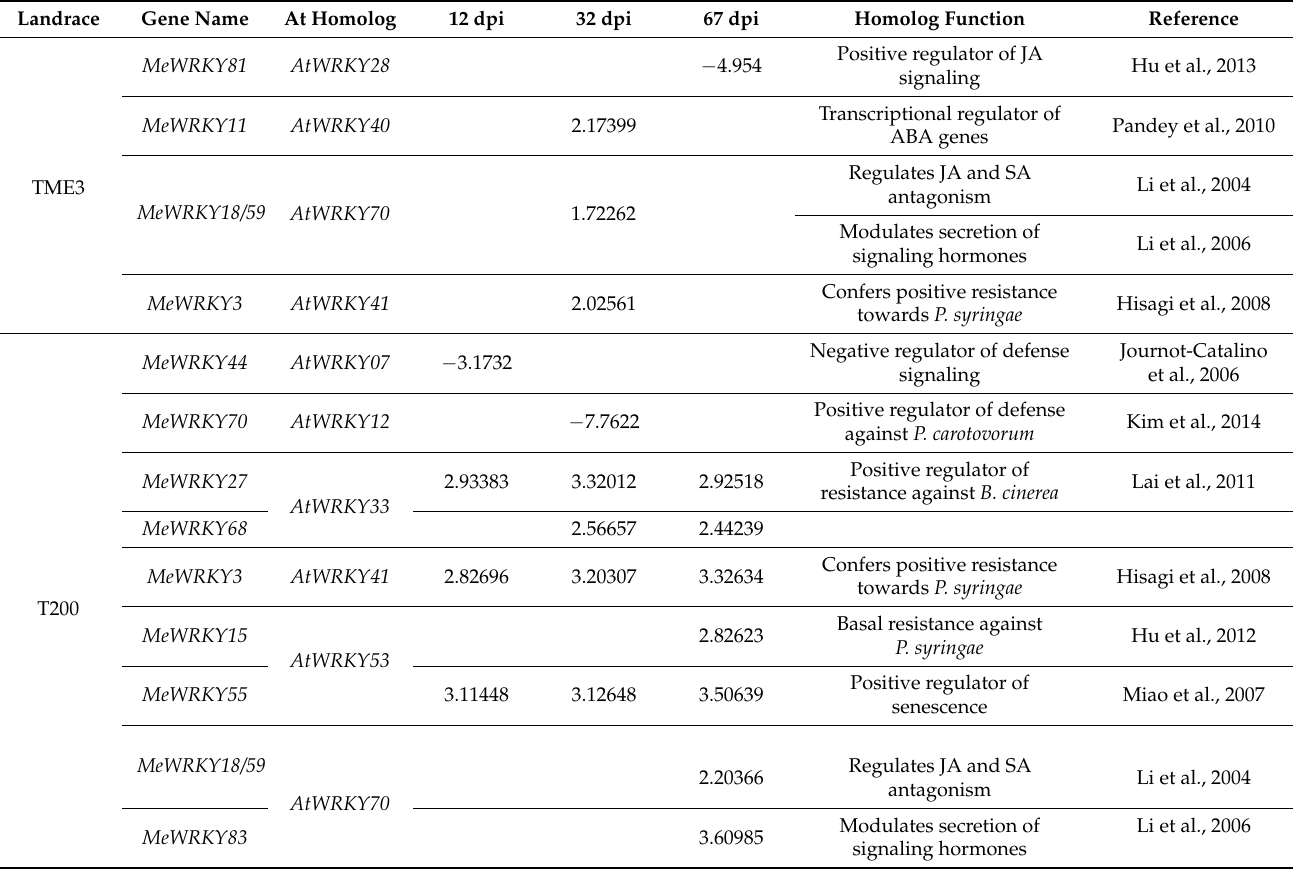
Table 1. Log 2 fold change in expression of MeWRKY s and the functions of their Arabidopsis homologs in susceptible T200 and tolerant TME3 landraces at 12, 32 and 67 days post infection (dpi) with South African cassava mosaic virus .